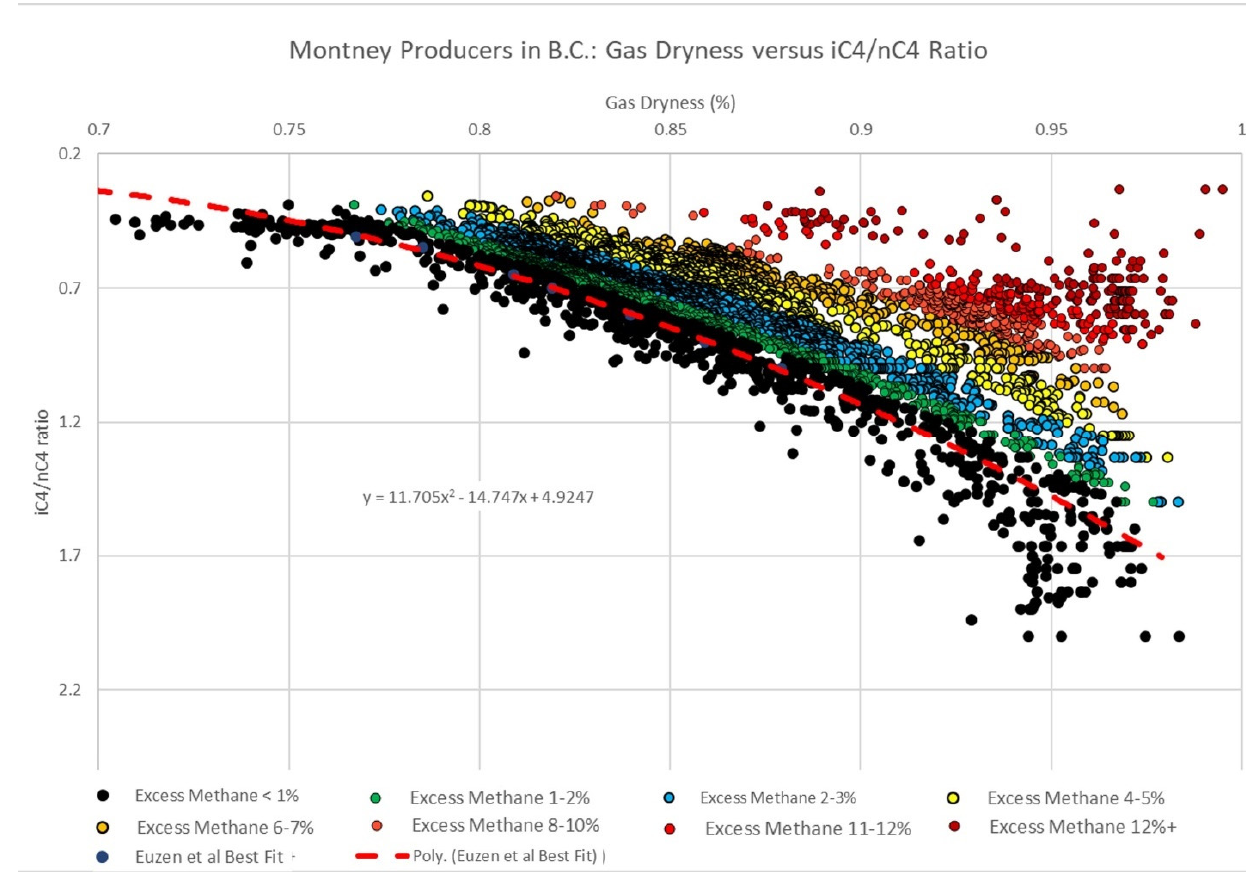
Figure 36. Cross plot of gas dryness and the iC4/nC4 ratio for all BC Montney producers at the time of this report. The iC4/nC4 is used as a maturity indicator with the line best representing the regional maturation trend from [4]. An excess methane percentage was calculated from the deviation away from the expected gas composition of the regional maturation trend. Wells that have high excess methane (i.e., red colours) have a greater ex situ (migrated) gas content compared to wells noted by black symbols. Wells represented by black or green symbols have lower ex situ gas contents, and the hydrocarbons are the result of in situ generation that is typical of a self-sourcing reservoir compared to the AB Montney producers outlined in Figure 37.